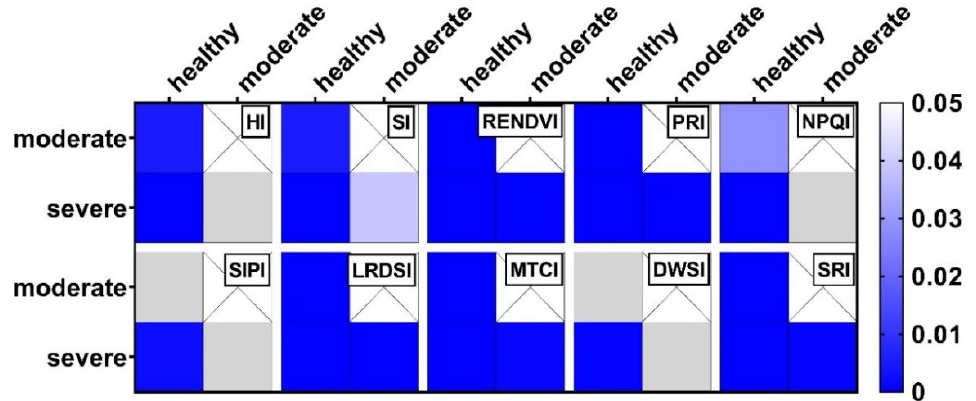
Figure 8. Heat map of p values for different indices calculated based on Dataset (A). Cross means no data, and gray box means not significant.